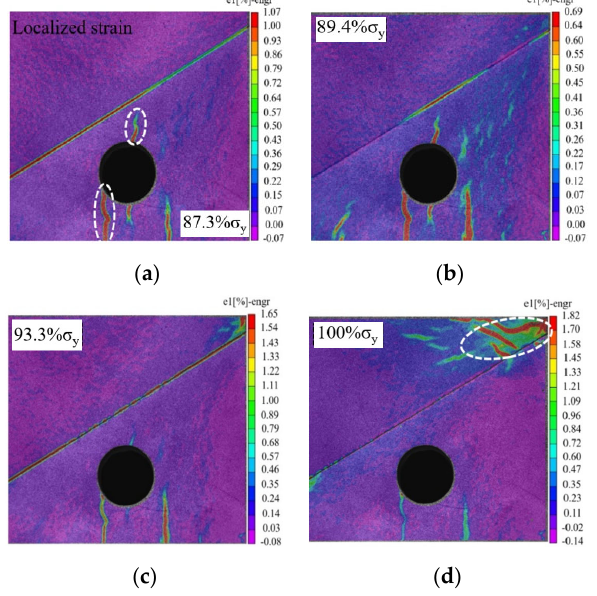
Figure 22. Evolution process of the major principal strain field of sample O. ( a ) 87.3% σ y ; ( b ) 89.4% σ y ; ( c ) 93.3% σ y ; ( d ) 100% σ y .